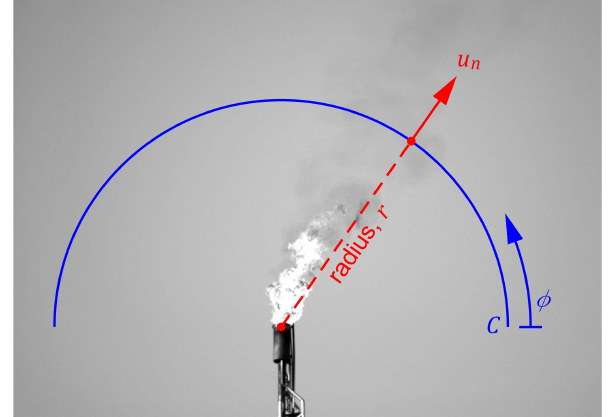
Figure 1. Sample sky-LOSA image of the flare and atmospheric plume, which is under slight crosswind in this example. A control surface ( C ) is shown in blue, which is defined by its constant ra- dius ( r ) and the angle φ . At each point on the control surface, the mass column density ( ρ (cid:48) s (r,φ) , not shown) is computed via care- ful consideration of radiative effects along the lines of sight (per- pendicular to the image plane) that compose the control surface. Additionally, the path-averaged normal plume velocity ( u n (r,φ)) is computed via image correlation velocimetry. The instantaneous mass emission rate is computed by integrating the product of these over the control surface defined by rd φ